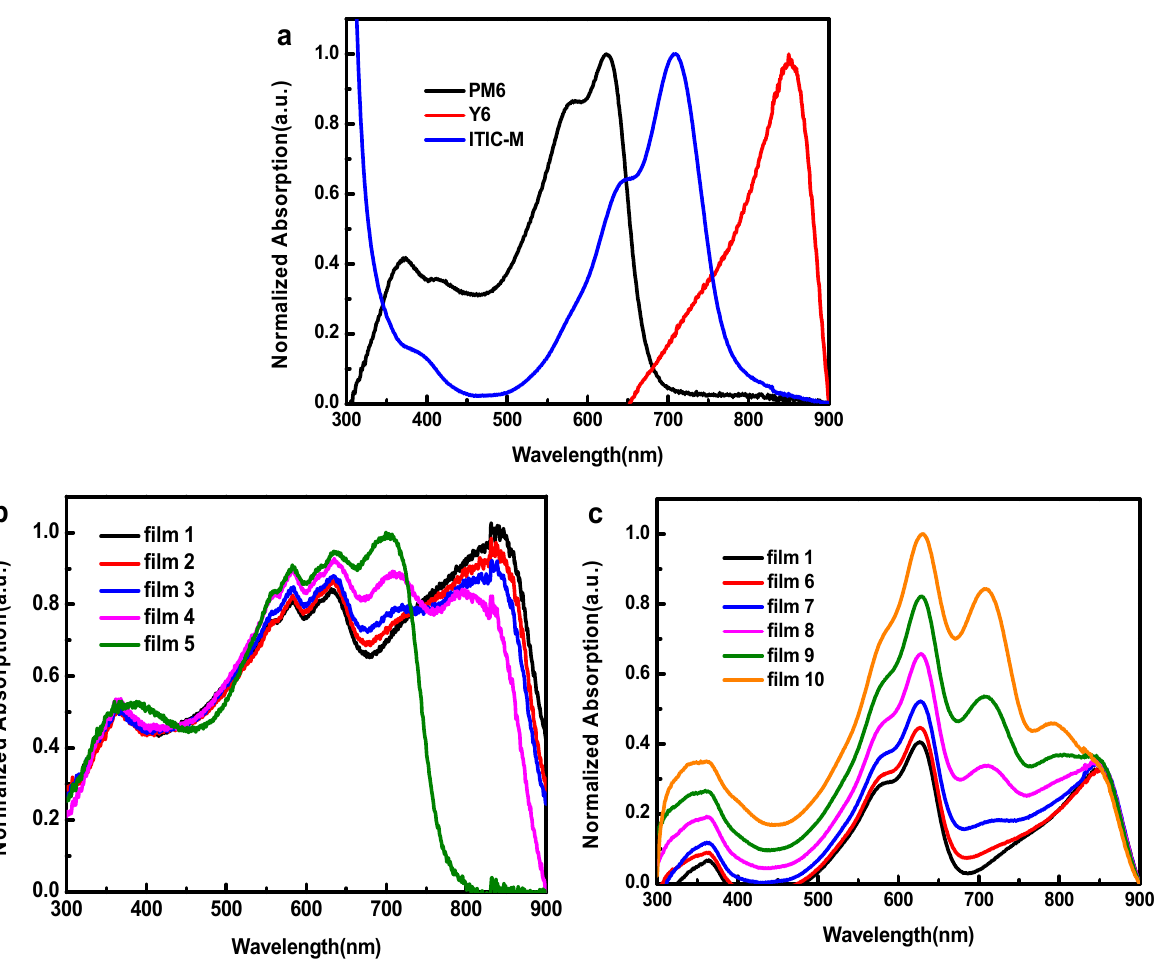
Figure 2. Absorption spectra of ( a ) pure PM6, Y6 and ITIC-M films normalized, respectively, at their peak, ( b ) blend films